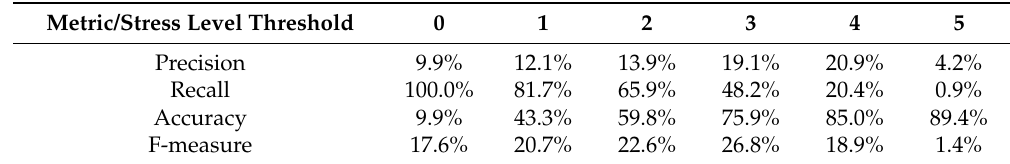
Table 4. Performance metrics per stress level threshold.